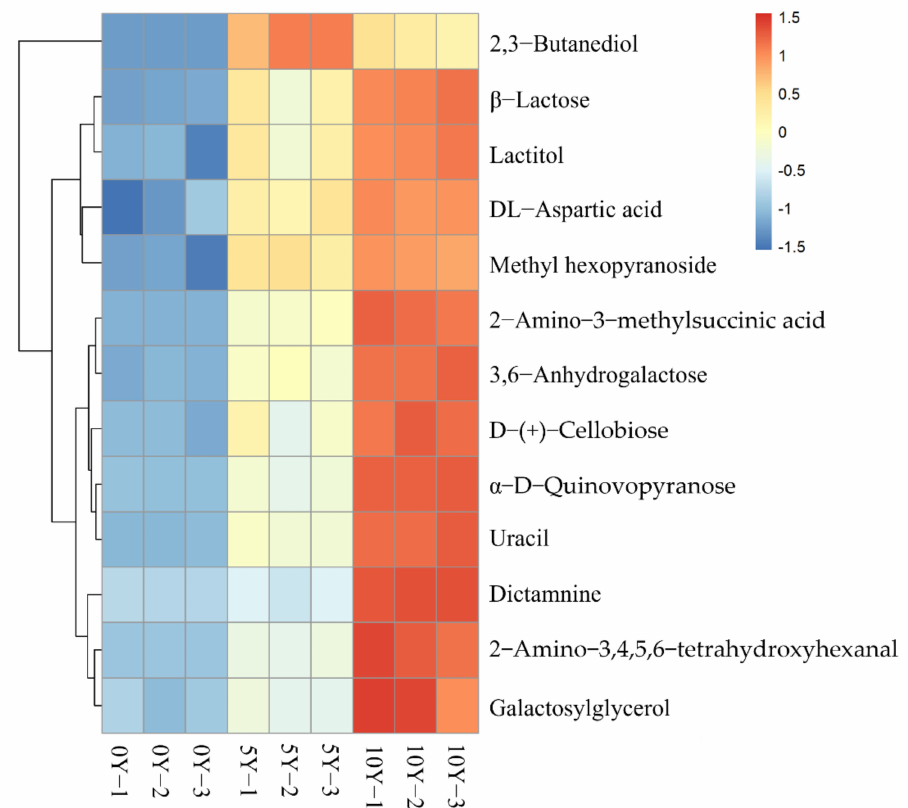
Figure 4. Hierarchical clustering analysis heat map of the main differential metabolites in ultra-long- term industrially fermented kohlrabi